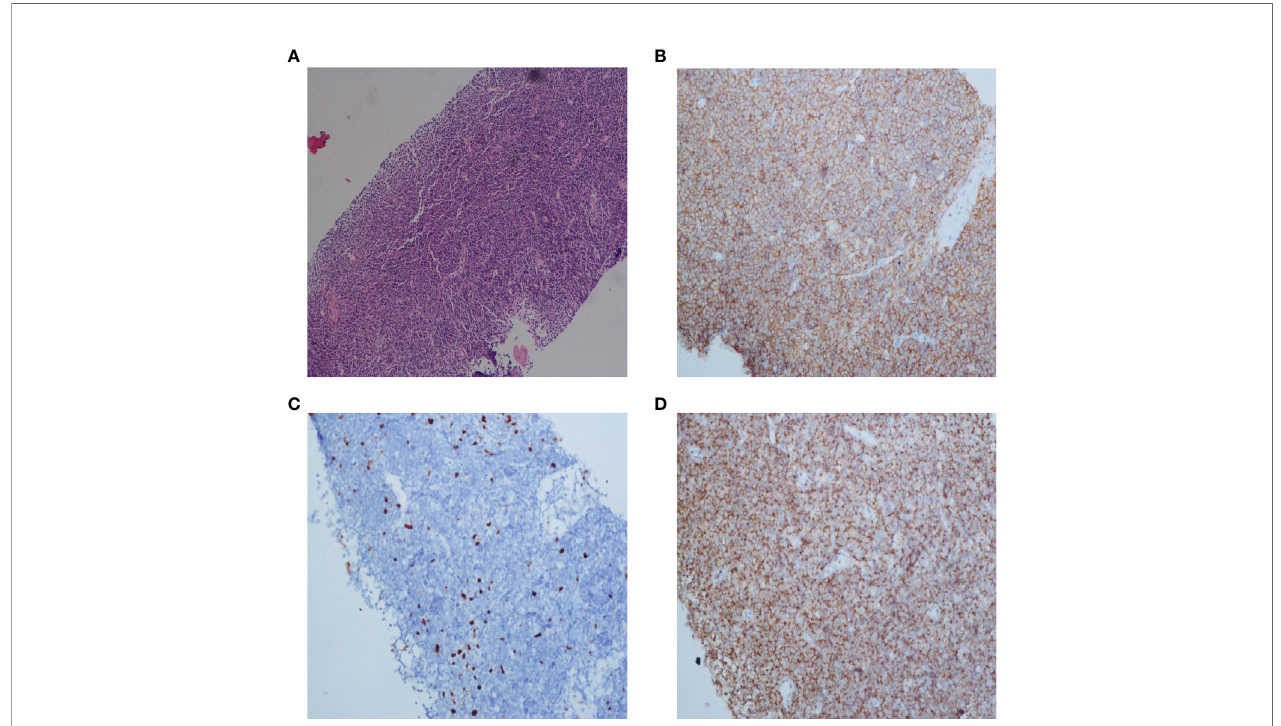
FIGURE 3 | Histopathology and immunohistochemistry (IHC) of the lymph node of this patient. Microscopic observation (10×) of H&E staining showed a dense diffuse lymphoid cells in fi ltration (A) . Immunohistochemical staining of CD20 and Bcl-2 expression (20×) showed that tumor cells were positive for CD20 and Bcl-2, respectively (B, D) . The Ki-67 proliferative index (20×) was low (C)